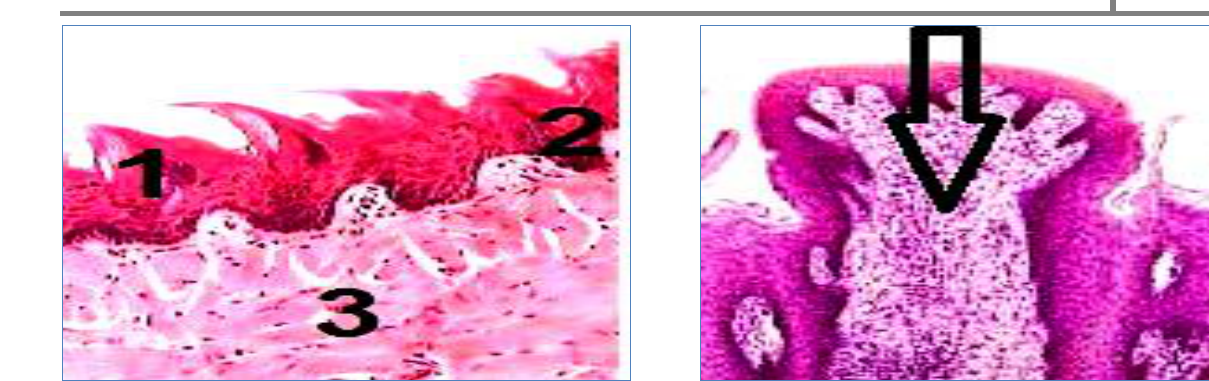
Figure, 5: Filiform papillae: Stratified squeamus epithelial tissue (1) lamina propria (2) skeletal muscles (3) (H and E) stain 100X.